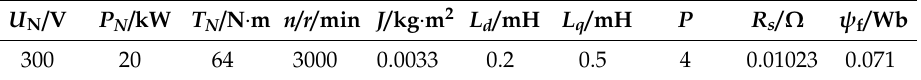
Table 1. The simulation parameters of the PMSM.